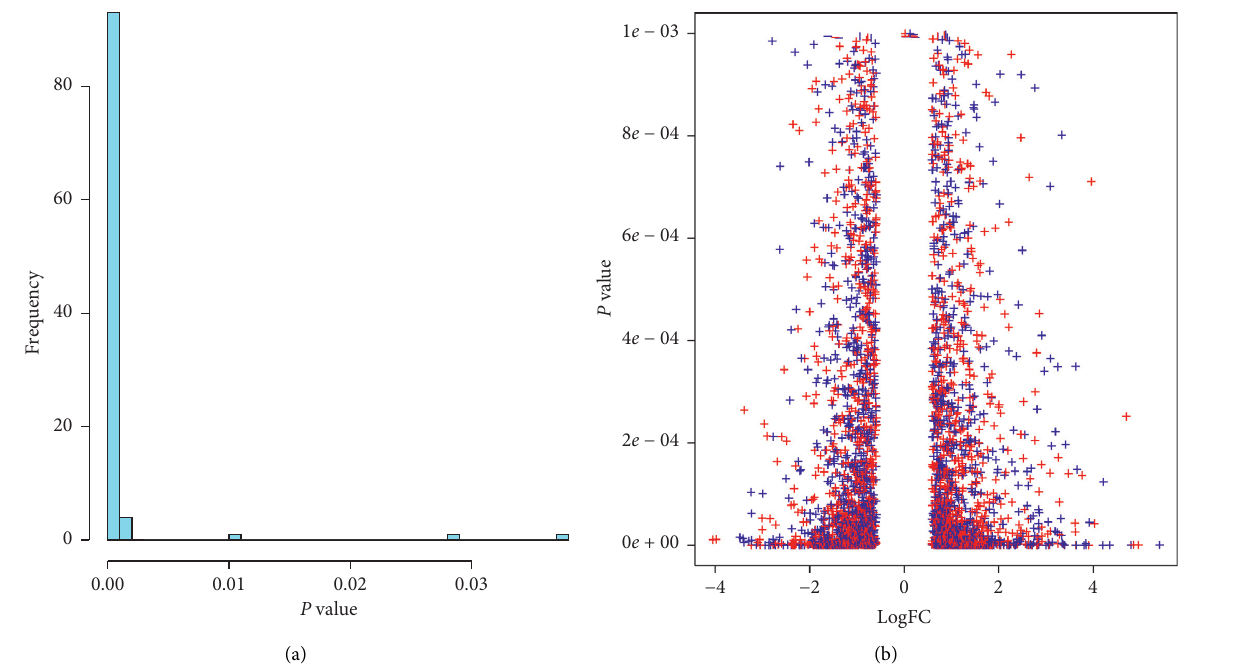
Figure 5: The genes number distribution of P < 0 . 001 and the correlation LogFC and P value.